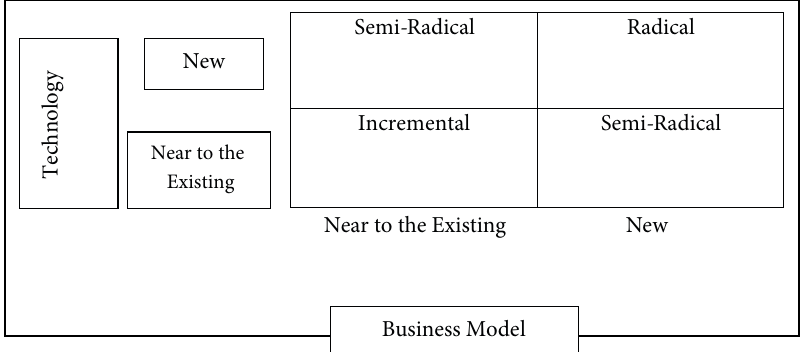
Fig. 1. Innovation